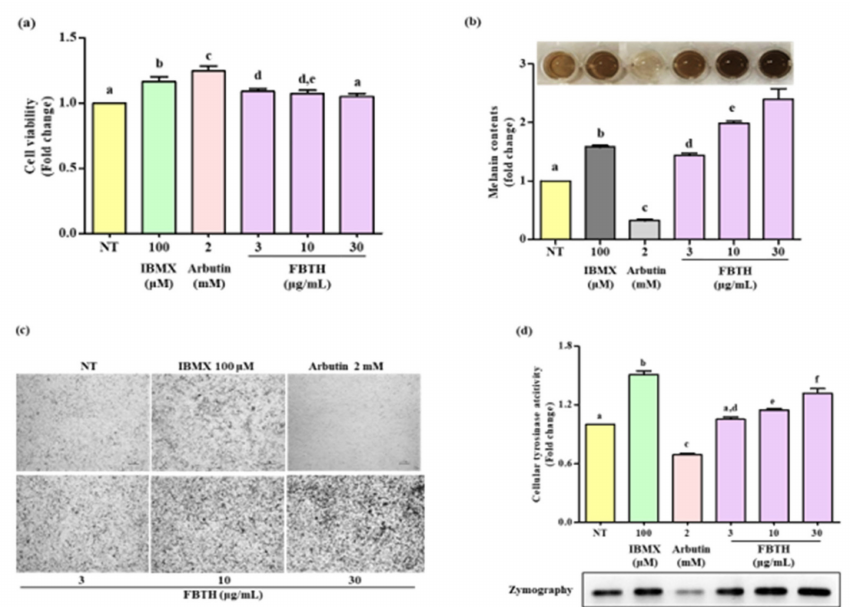
Figure 3. Effects of melanogenesis by FBTH in Melan-A cells. ( a ) Cells (1 × 105 cells/mL) were seeded in 24-well plates and incubated with the FBTH or IBMX or arbutin for three days, and the cell viability was measured by the MTT assay. ( b ) Cells were treated with samples or compounds for three days; after washing with PBS twice, the cells were collected and dissolved in NaOH, then the melanin contents were measured at 405 nm. IBMX was used as a positive control, and arbutin was used as a negative control. ( c ) Cells were treated with samples or compounds for three days, and then washed using PBS twice and photographed using a Nikon microscope and camera (Eclipse, TE-2000U, Nikon, Tokyo, Japan). ( d ) Melan-A cells were cultured with FBTH for three days. After the tyrosinase was extracted, the cellular tyrosinase activity and zymography were performed according to the described method. Data are expressed as the mean ± SD ( n = 3). All tests were performed in triplicate. Different letters stand for statistically significant each other ( p < 0.05) performed by one-way ANOVA followed by Tukey’s